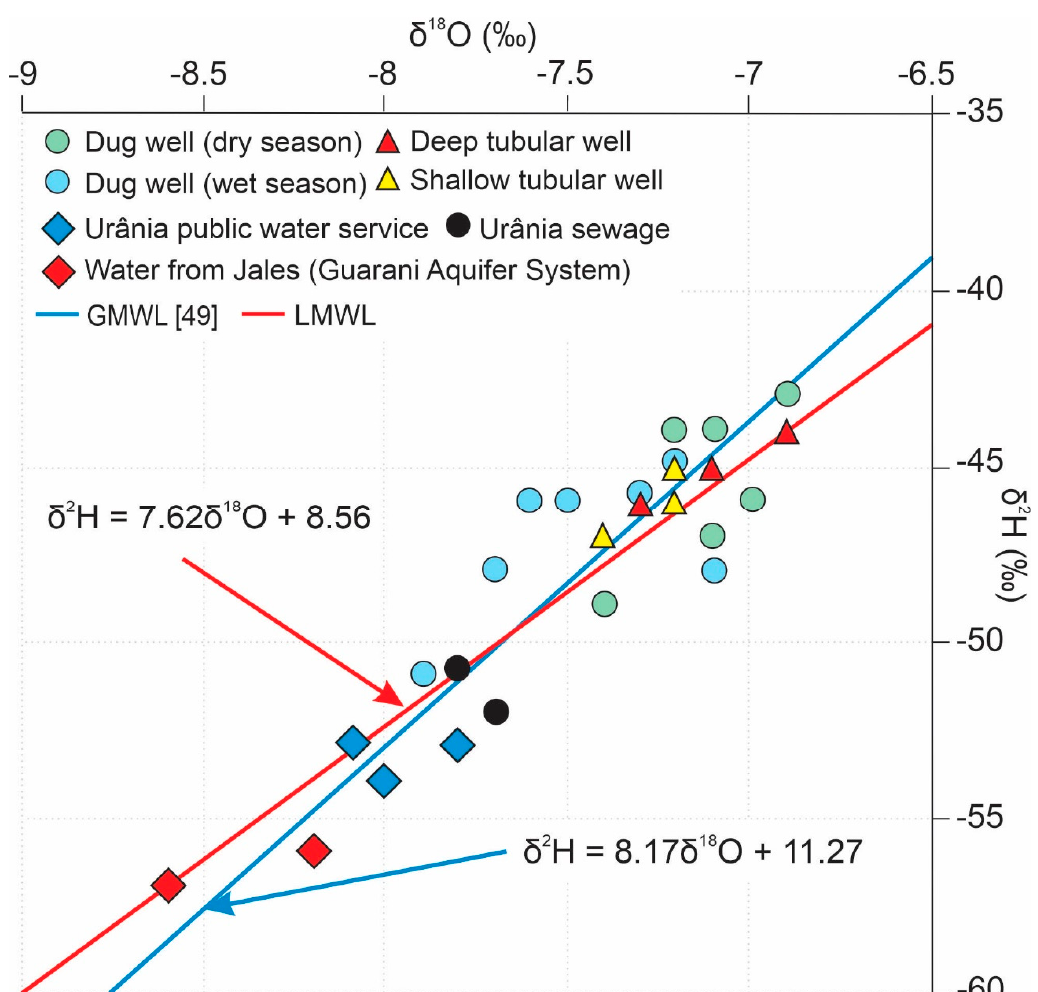
Figure 3. Stable isotope signature of groundwater in Ur â nia. Global Meteoric Water Line (GMWL) is based on Rozanski et al. (1993) [49], and de Local MWL was established in this study. There are six groups of groundwater in Ur â nia (Table 2). Although there is a great dispersion and overlap of the results, it is possible to determine that the waters of the SZ (urban wells) have slightly more negative average signatures during the rainy season ( δ 18 O = − 7.5% (cid:24) ) than in the dry period (from δ 18 O = 7.1% (cid:24) ), and the waters of the deepest wells, which extract water from IZ and DZ, equal these waters ( δ 18 O = 7.1% (cid:24) , from − 6.8 to − 7.6% (cid:24) ). These results are consistent with the conceptual model, indicating an aquifer with rapid recharges during the summer and with more negative signature waters. That part of this recharge is the result of losses in the water and sewage network, which originates in the mixture of the Guarani Aquifer System ( δ 18 O = − 8% (cid:24) ), which is supplied from Jales (14 km) and with some waters of the deep zone of the Adamantina Aquifer ( δ 18 O = − 7.25% (cid:24) ) to a lesser extent. Sewage water has a slightly more positive isotopic signature ( δ 18 O = − 7.75% (cid:24) ) than public water ( δ 18 O = − 8.0% (cid:24) ), suggesting that the population still uses water from the Adamantina Aquifer extracted from private tubular and urban